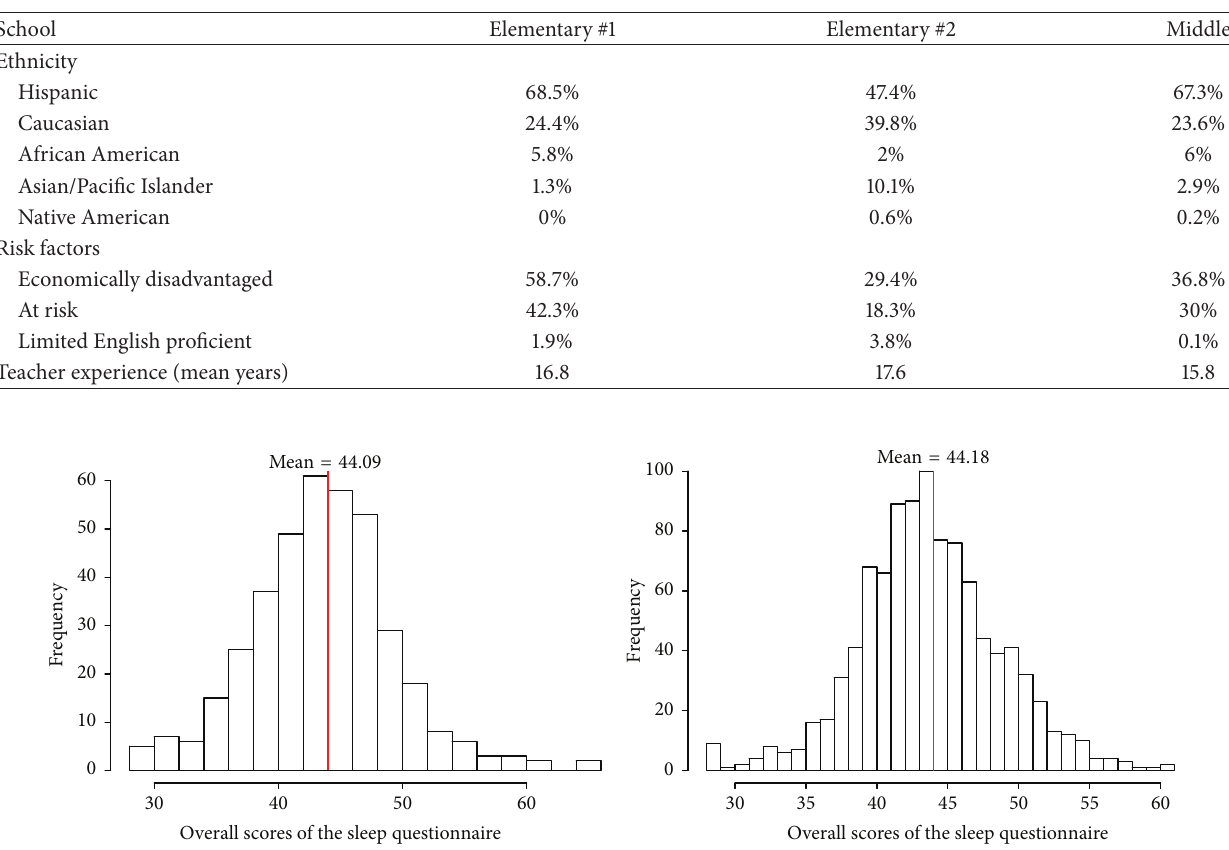
Table 1: Demographic characteristics of the students.